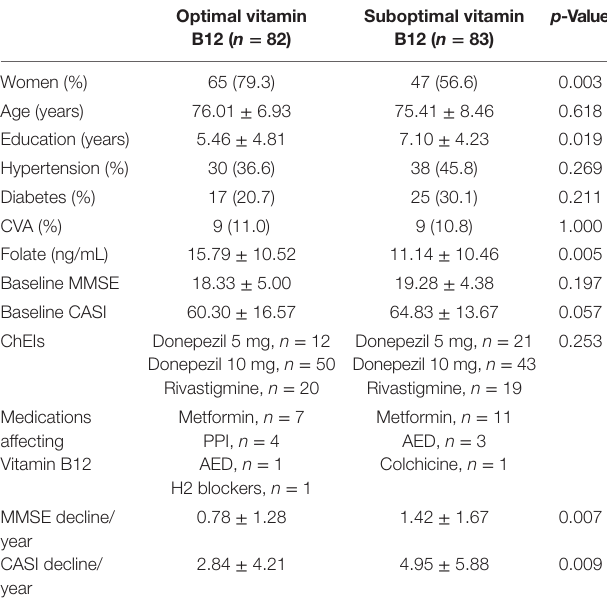
TaBle 1 | Demographic data of all patients categorized into optimal vitamin B12 ( > 436 ng/L) and suboptimal ( ≤ 436 ng/L) groups.